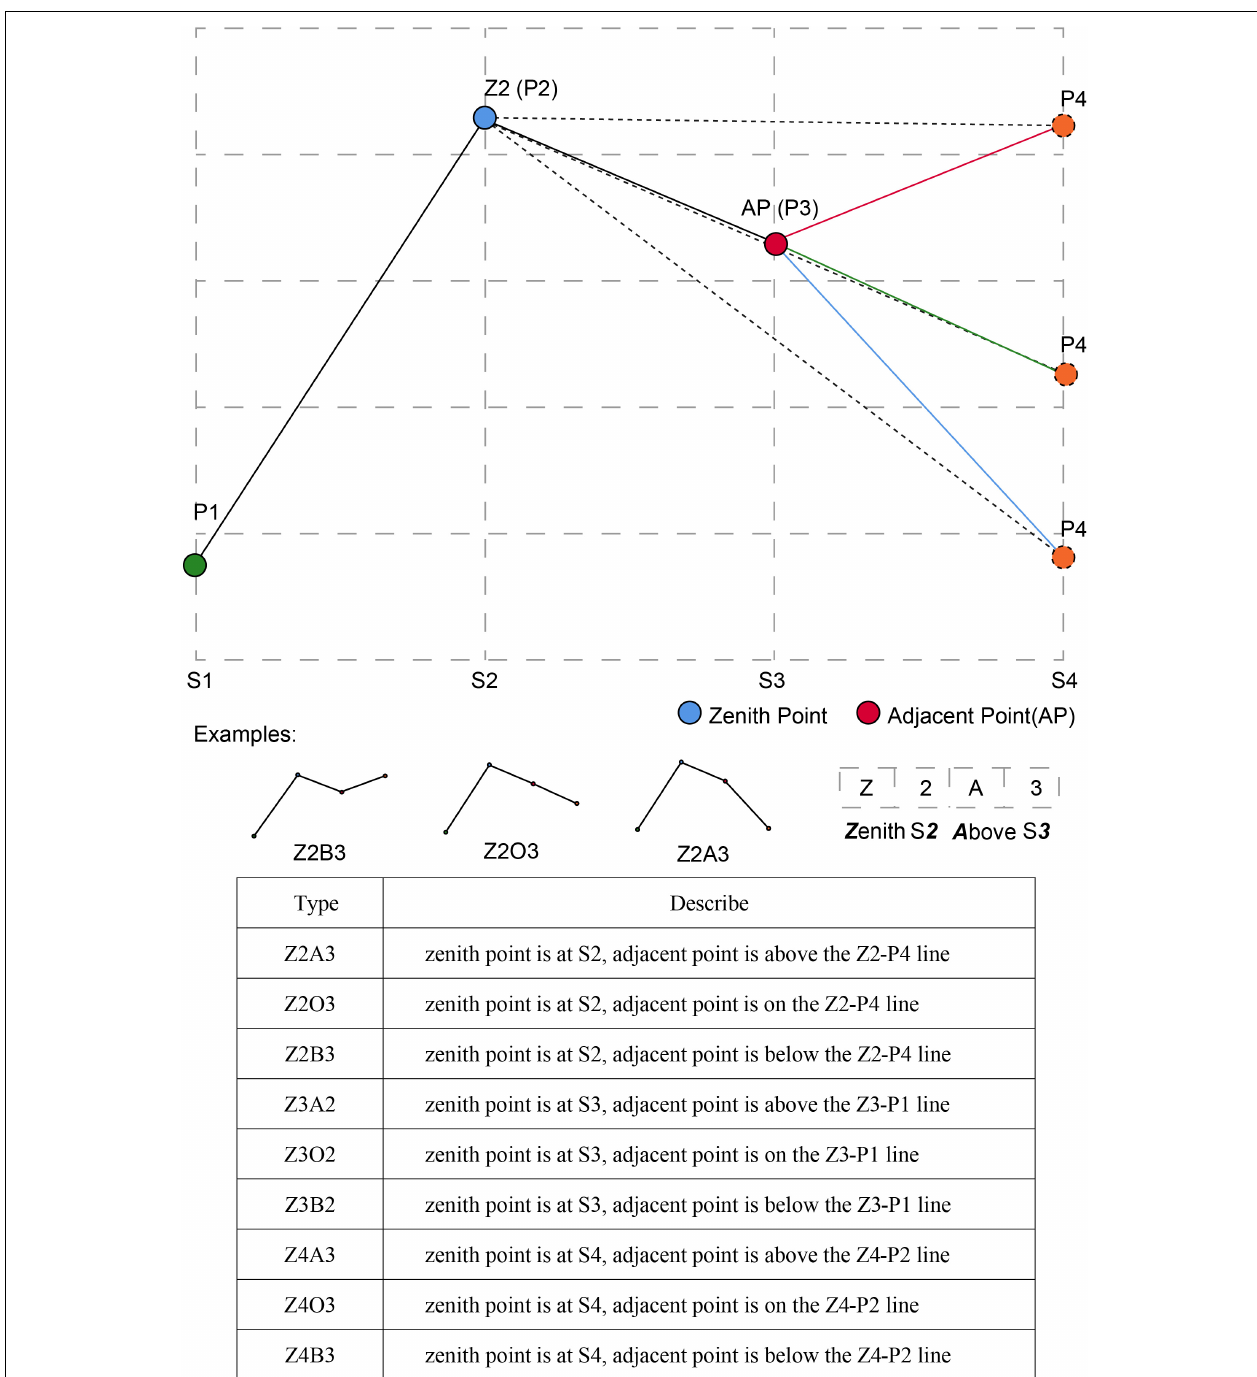
FIGURE 5 | The naming convention of different typical curves and examples in this study.